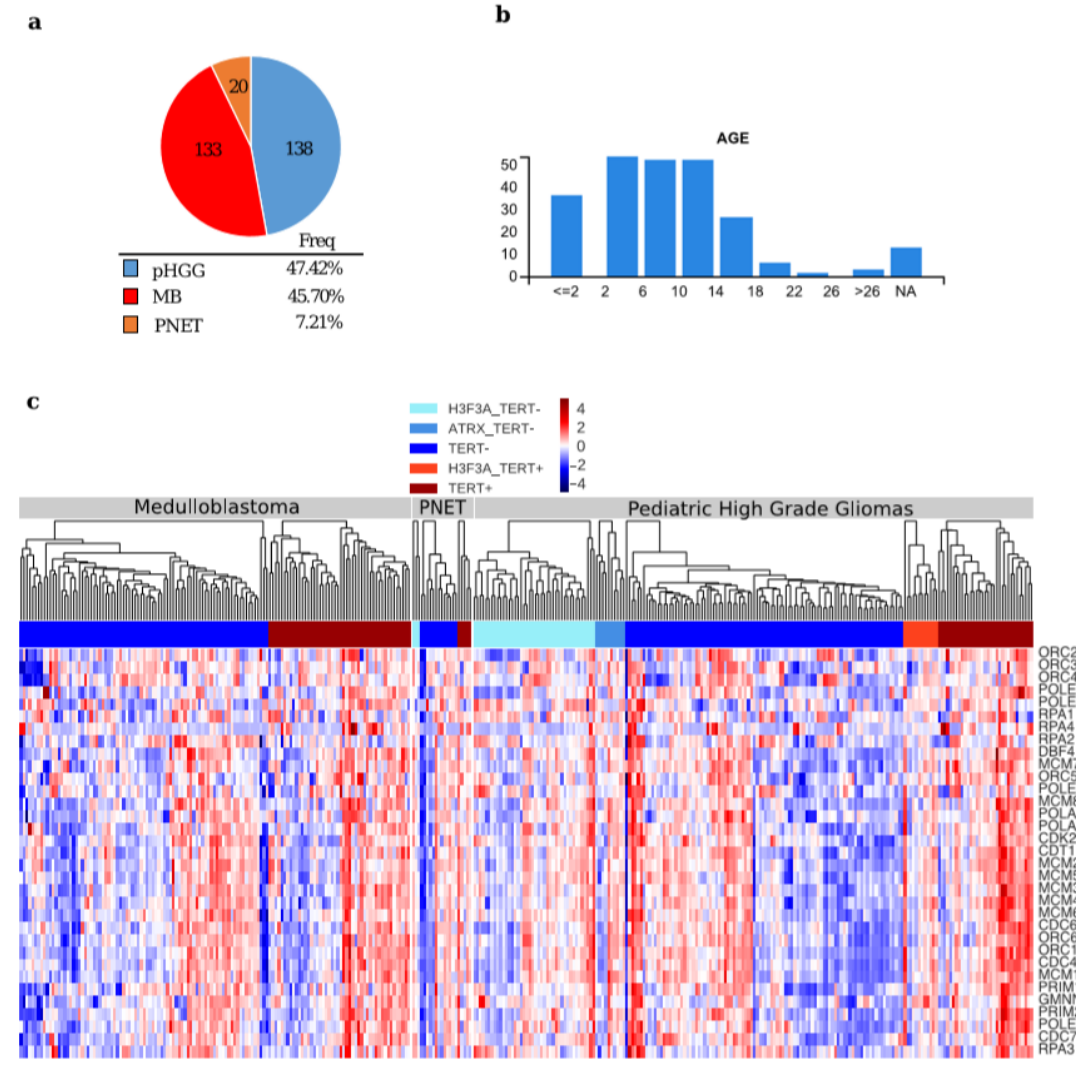
Figure 2. General features in paediatric brain tumor samples used for comparison ( a ) Pie chart depicting the tumor samples from the pediatric cBio Portal used in the analysis; ( b ) Diagrams showing the di ff erent ages of the patients from the pediatric cBio Portal; ( c ) Hierarchical clustering of the expression values of the genes of the Reactome pathway: “Activation of the pre-replicative complex” (Homo sapiens R-HSA-68962) in samples from the paediatric cBio Portal. The samples were divided per tumor type, according to the presence of mutations in H3F3A and / or ATRX, and TERT expression level (TERT + : Z-score > 0, TERT − : Z-score < 0).